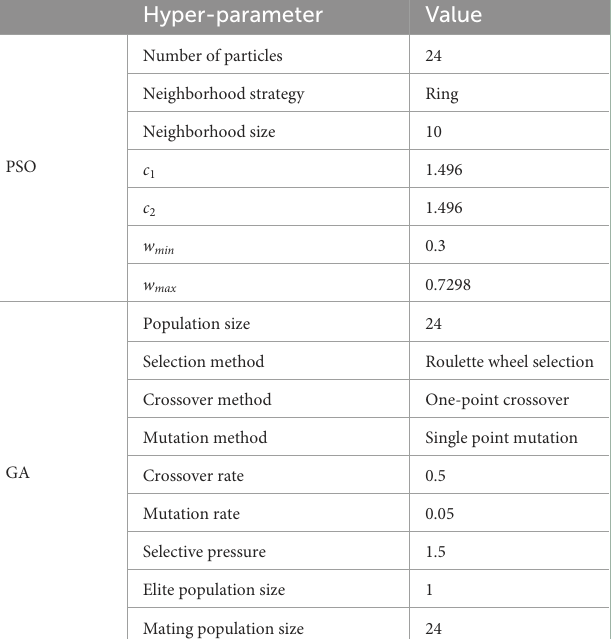
TABLE 3 PSO and GA configuration settings.